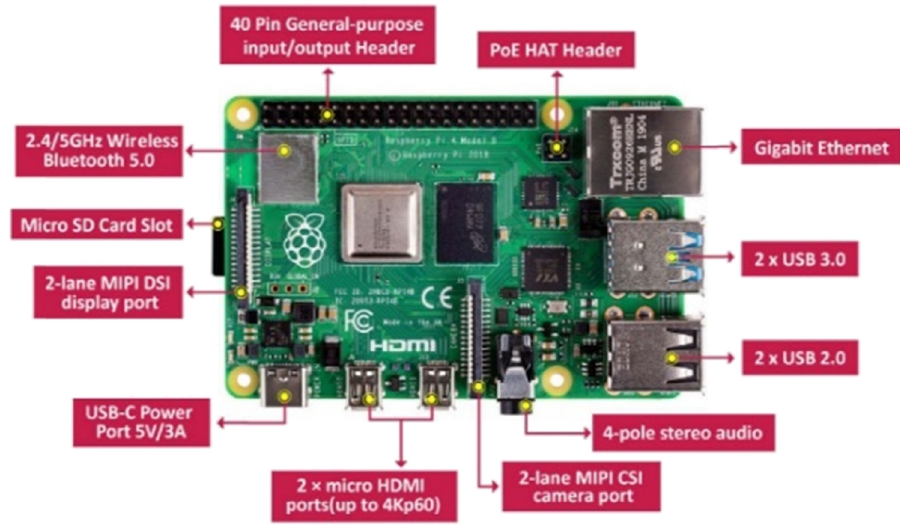
Figure 3: Components of the Raspberry Pi similar to a general